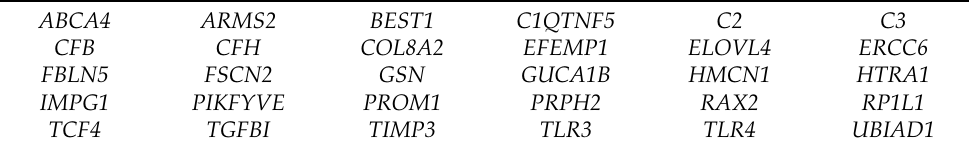
Table 1. List of genes included in the enrichment